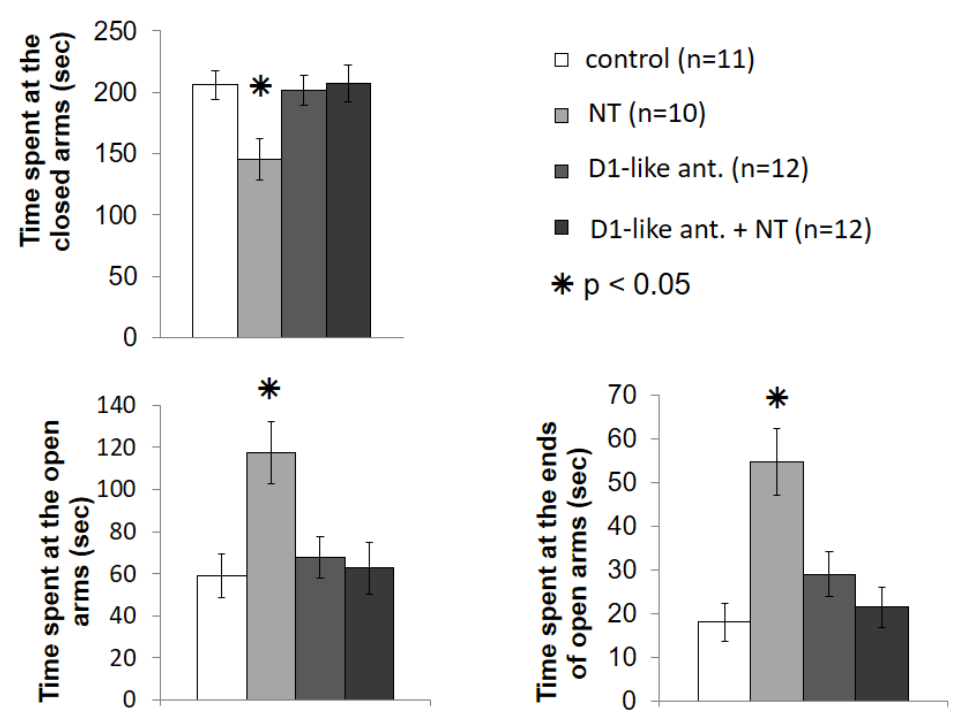
Figure 4. Effects of D1-like DA receptor antagonist SCH23390 pretreatment on the anxiolytic effect of NT in the VP in EPM test. Columns represent mean time spent at the closed arms, time spent at the open arms, and time spent at the ends of the open arms, respectively (±S.E.M.). Control group: rats received two microinjections of vehicle (n = 11). NT group: animals microinjected with vehicle + 100 ng NT (n = 10). D1-like ant. group: animals received 1 μ g SCH23390 + vehicle (n = 12). D1-like ant. + NT group: effect of microinjections of 100 ng NT after 1 μ g SCH23390 pretreatment (n = 12). For further explanation, refer to the text. *: p < 0.05.